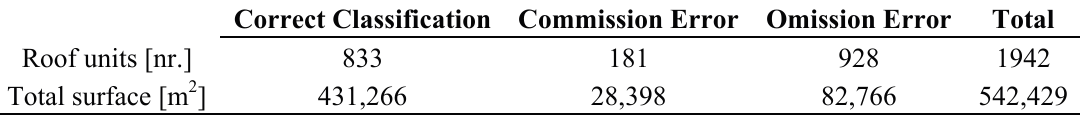
Table 2. Summary of